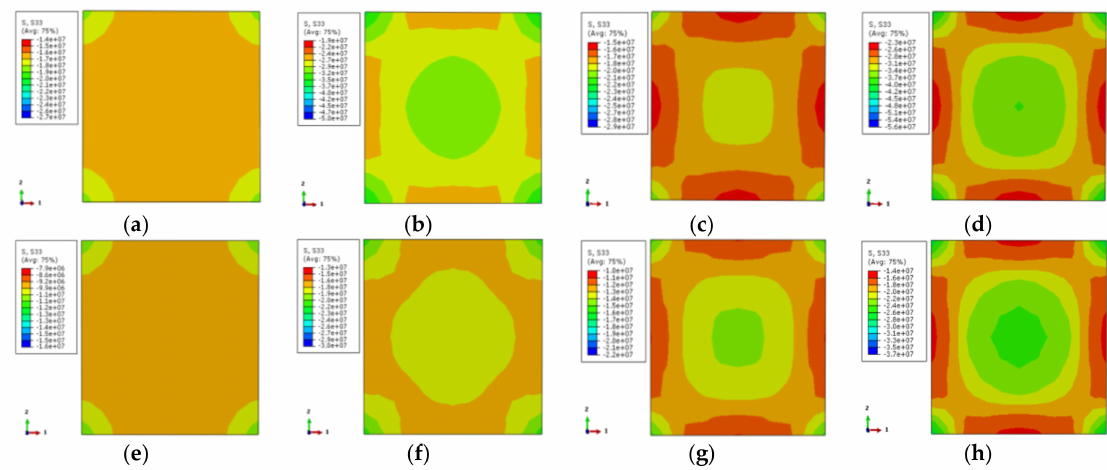
Figure 13. The vertical stress distribution of concrete ( a ) DS-200-0-0.75; ( b ) DS-200-0-1; ( c ) DS-200-0.75; ( d ) DS-200-1; ( e ) DS-600-0-0.75; ( f ) DS-600-0-1; ( g ) DS-600-0.75; ( h ) DS-600-1.